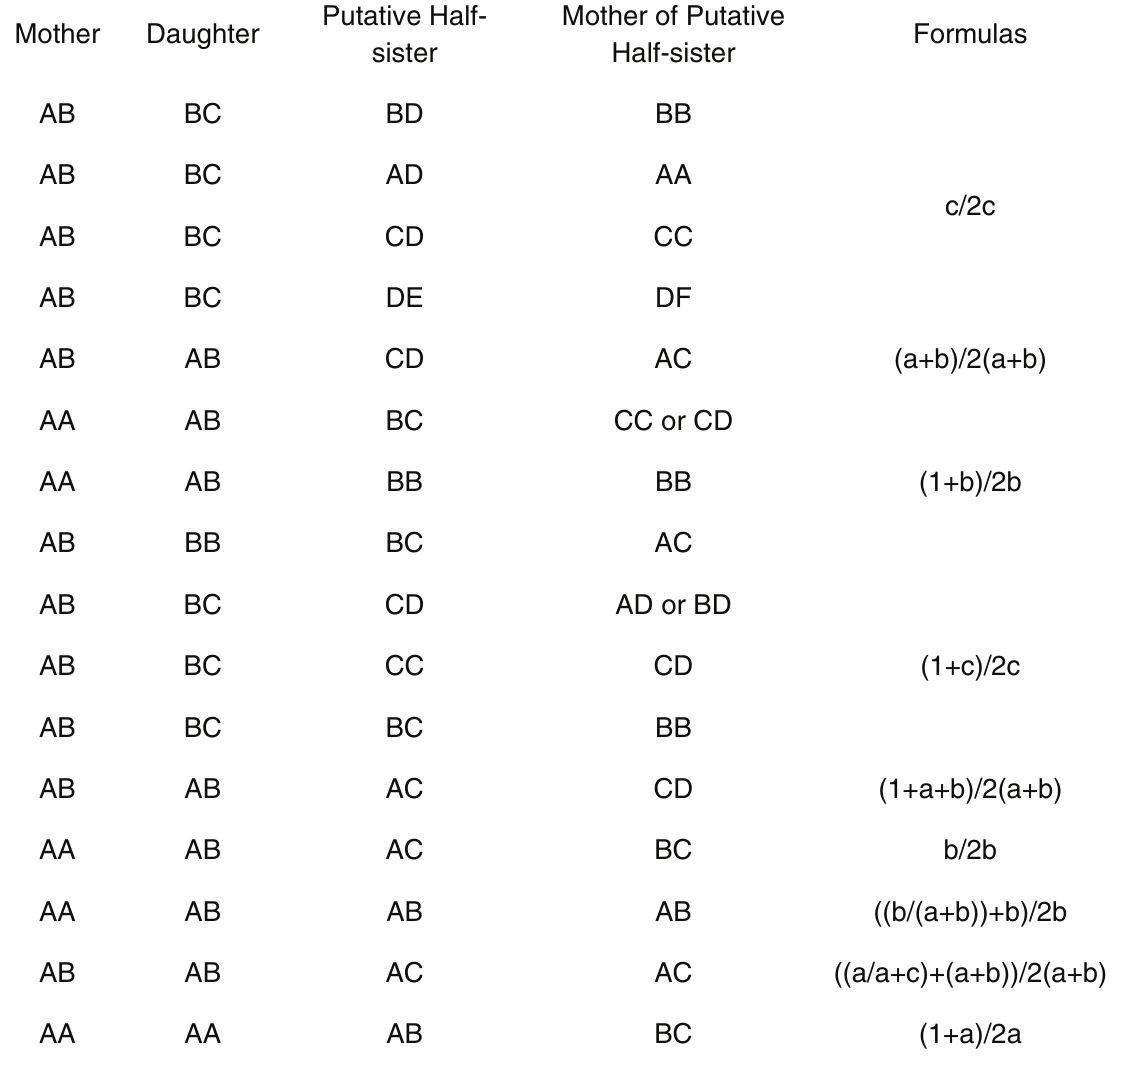
Table S5 - Formulas to calculate PI considering the profile configurations depicted with AS STRs, in case